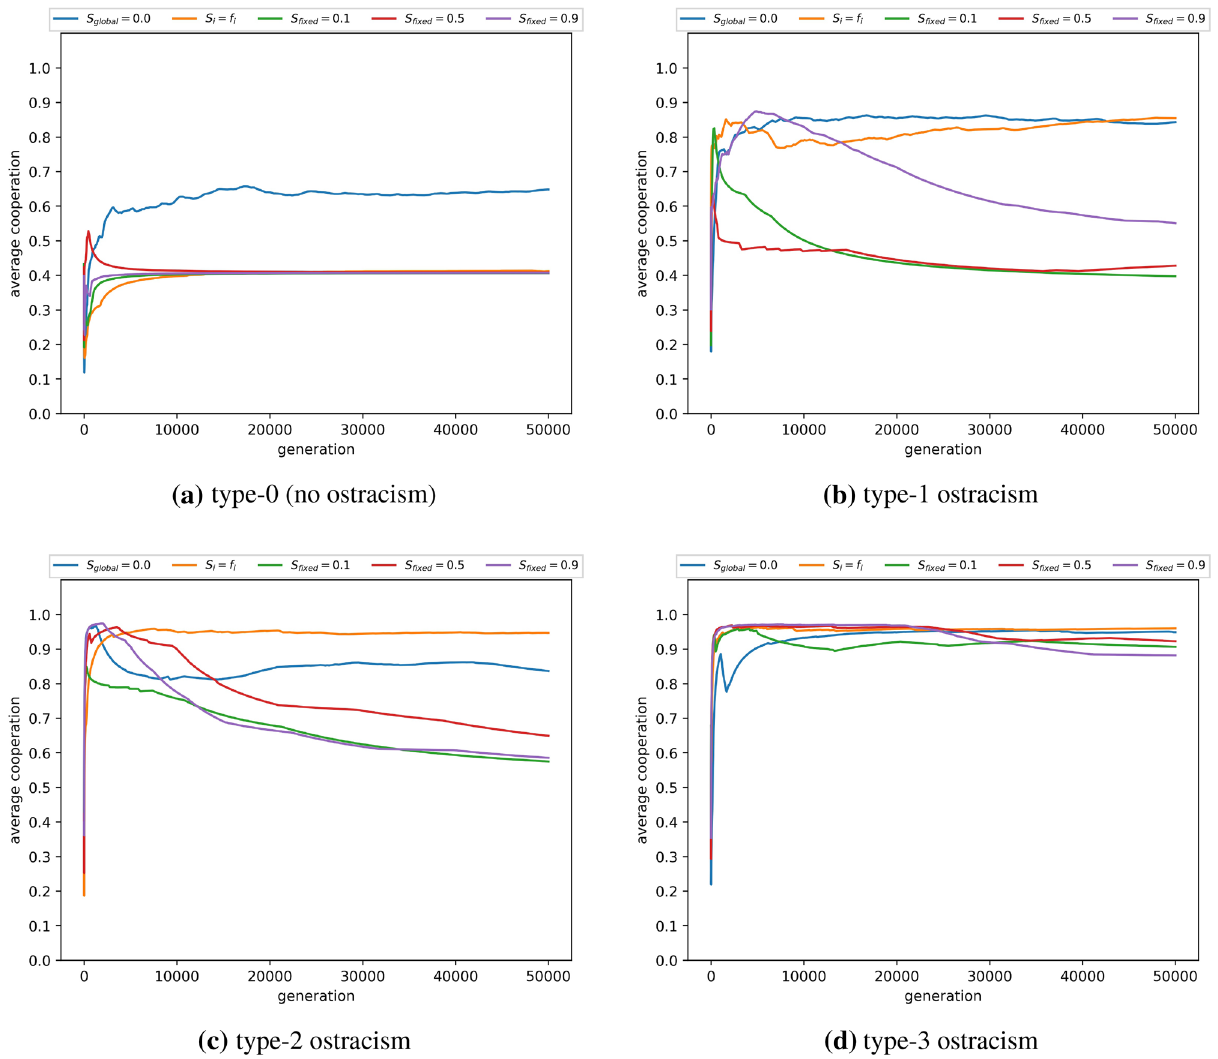
Figure 1. Average cooperation per generation for type 1 ( b ), 2 ( c ) or 3 ( d ) ostracism. Type 0 ( a ) represents a scenario without ostracism. Ostracism is performed by each agent i with a probability equal to the agent’s fusion level f i . Average cooperation indicates the cumulative frequency of cooperative interactions, defined as the total number of donations made in all preceding generations as a proportion of the total number of games played in all preceding generations. Agents interact randomly with the other fused individuals within their in-group with fixed probabilities of S i ( S i = 0.1, 0.5, 0.9 ), or with a probability equal to their own current fusion level ( S i = f i ). S global indicates that all agents mix uniform randomly (i.e., S i = 0 ). The in-group of an agent i is defined as the subset of agents having at least same level of fusion as i (i.e., f i or greater). Agents interact randomly with the whole population with a probability equal to 1 − S i . Results are averaged over five randomly seeded runs. Number of agents N = 100 ; number of games per generation m = 5000 ; number of generations M = 50, 000 . Action rules and fusion levels are mutated at the rate of 0.01 per